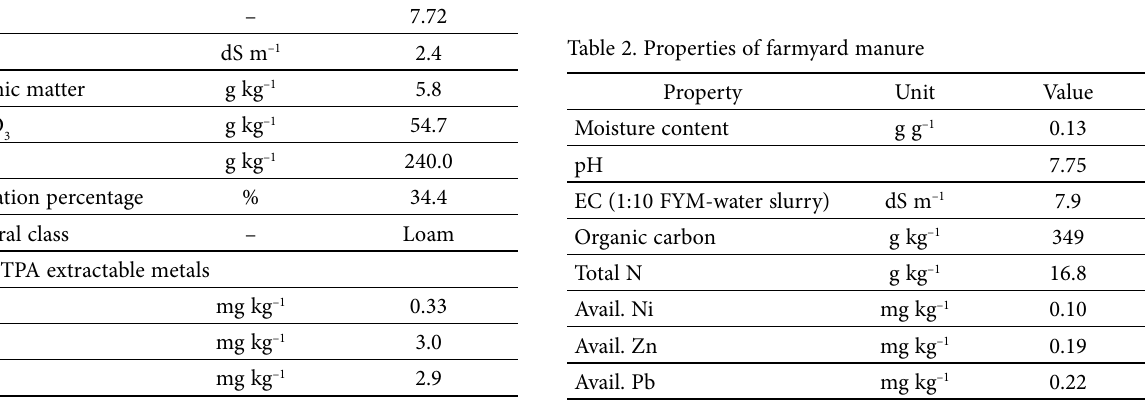
Table 1. Physical and chemical characteristics of soil used in the study Soil characteristics